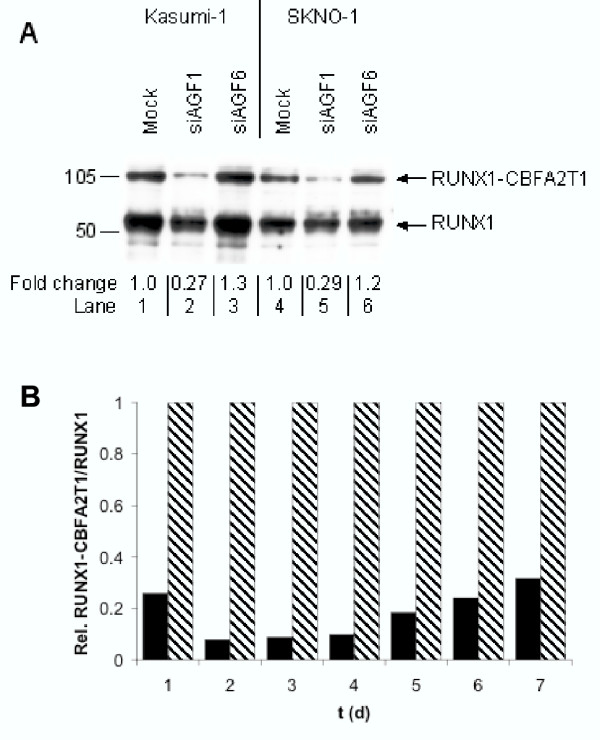
Depletion of RUNX1-CBFA2T1 protein by siRNAs A. RUNX1-CBFA2T1 and RUNX1 protein levels in siRNA-treated Kasumi-1 and SKNO-1 cells. Nuclear lysates were prepared 4 days after electroporation with 100 nM siRNAs and analyzed by immunoblotting. The electroporated cells and siRNAs are indicated on top. Arrows on the right mark RUNX1-CBFA2T1 and RUNX1 proteins. Markers are shown on the left, and the relative ratios between RUNX1-CBFA2T1 and RUNX1 are indicated below the blot. B. Time course of siRNA-mediated RUNX1-CBFA2T1 depletion. Kasumi-1 nuclear lysates were isolated at the indicated days after electroporation with 100 nM siRNA and analyzed by immunoblotting. Values were normalized to the control siRNA siAGF6.